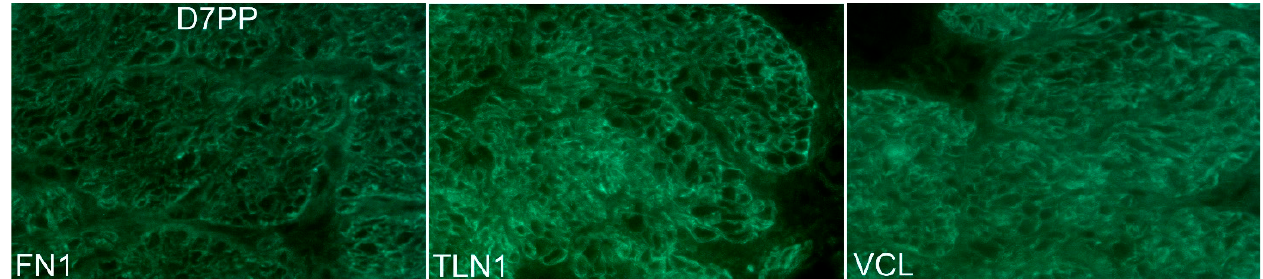
Figure 7. Integrin adhesion complexes (IACs) in sheep myometrium disassemble postpartum. Immunostaining for fibronectin (FN1), talin (TLN1), and vinculin (VCL) in the myometrium of ewes on Day 7 postpartum (D7PP) is shown. Similar to results for the alpha 5 integrin (ITGA5) and the beta 1 integrin (ITGB1) shown in Figures 3 and 4, the multimodular, mechanosensory ECM protein FN1 and intracellular mechanosensory cytoskeletal proteins TLN1 and VCL no longer assemble into IACs in the myometrium of postpartum ewes. The width of each field is 220 µm.